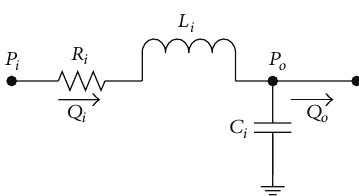
Figure 3: Electric circuit analog of the blood vessel segment. Flow through the model is defined by Q (mL/s). Pressures related to each compartment are marked by P (mmHg). Resistors are denoted by R (mmHg ⋅ s/mL), while capacitors and inductances are denoted by C (mL/mmHg) and L (mmHg ⋅ s 2 /mL),